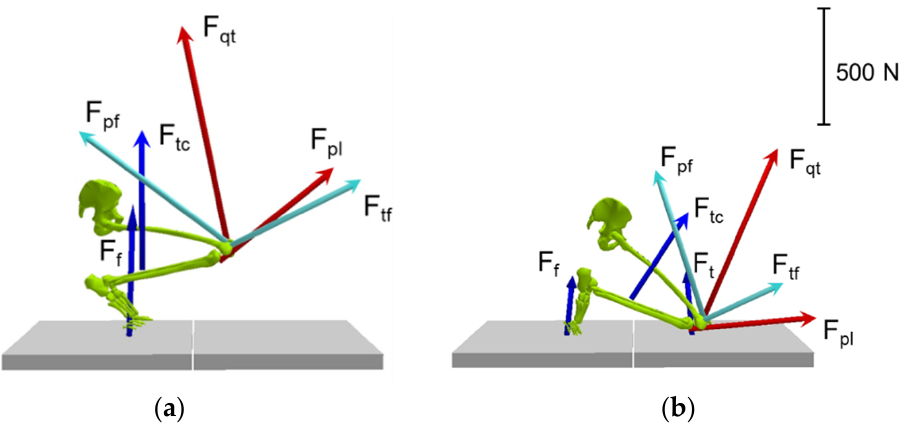
Figure 7. Examples of force vector graphics of ( a ) squatting and ( b ) deep kneeling. For further details see Figure 2.